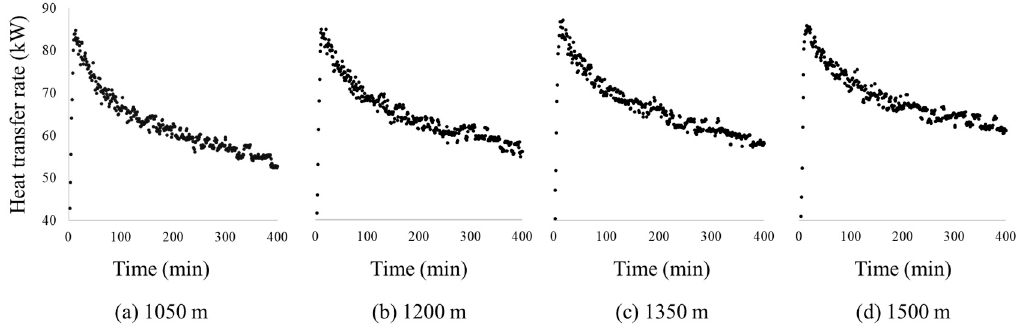
Figure 14. Heat transfer rate change according to the GHEX length. ( a )1050 m; ( b )1200 m; ( c ) 1350 m; ( d ) 1500m.